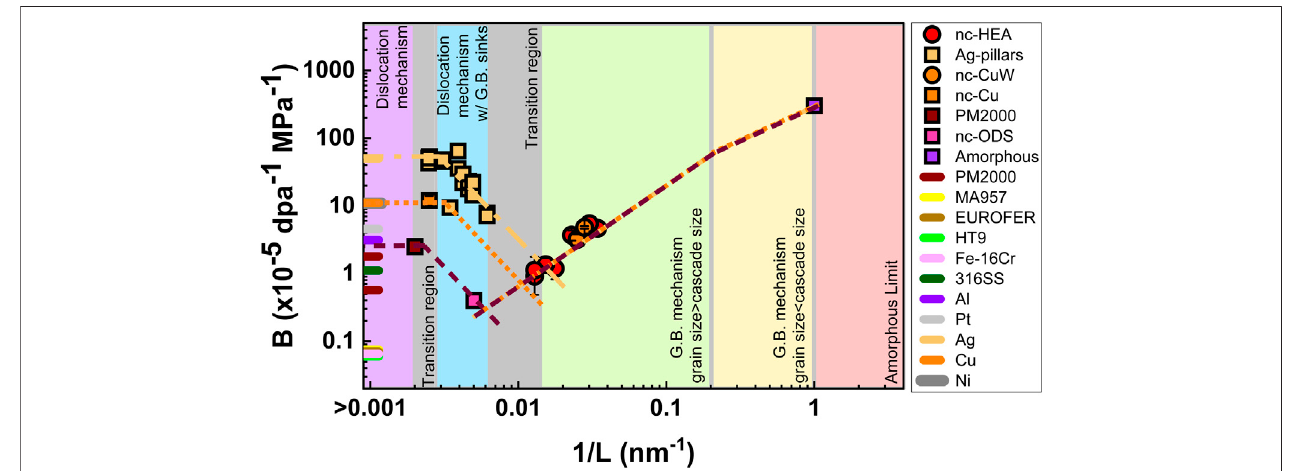
FIGURE 9 | The schematic diagram for IIC compliance (B) as a function of inverse grain sizes (1/L). The fi gure is divided into different parts, representing different control mechanisms during the creep process [Reprinted with permission from Jawaharram et al. (2020) Copyright 2020 by Elsevier].